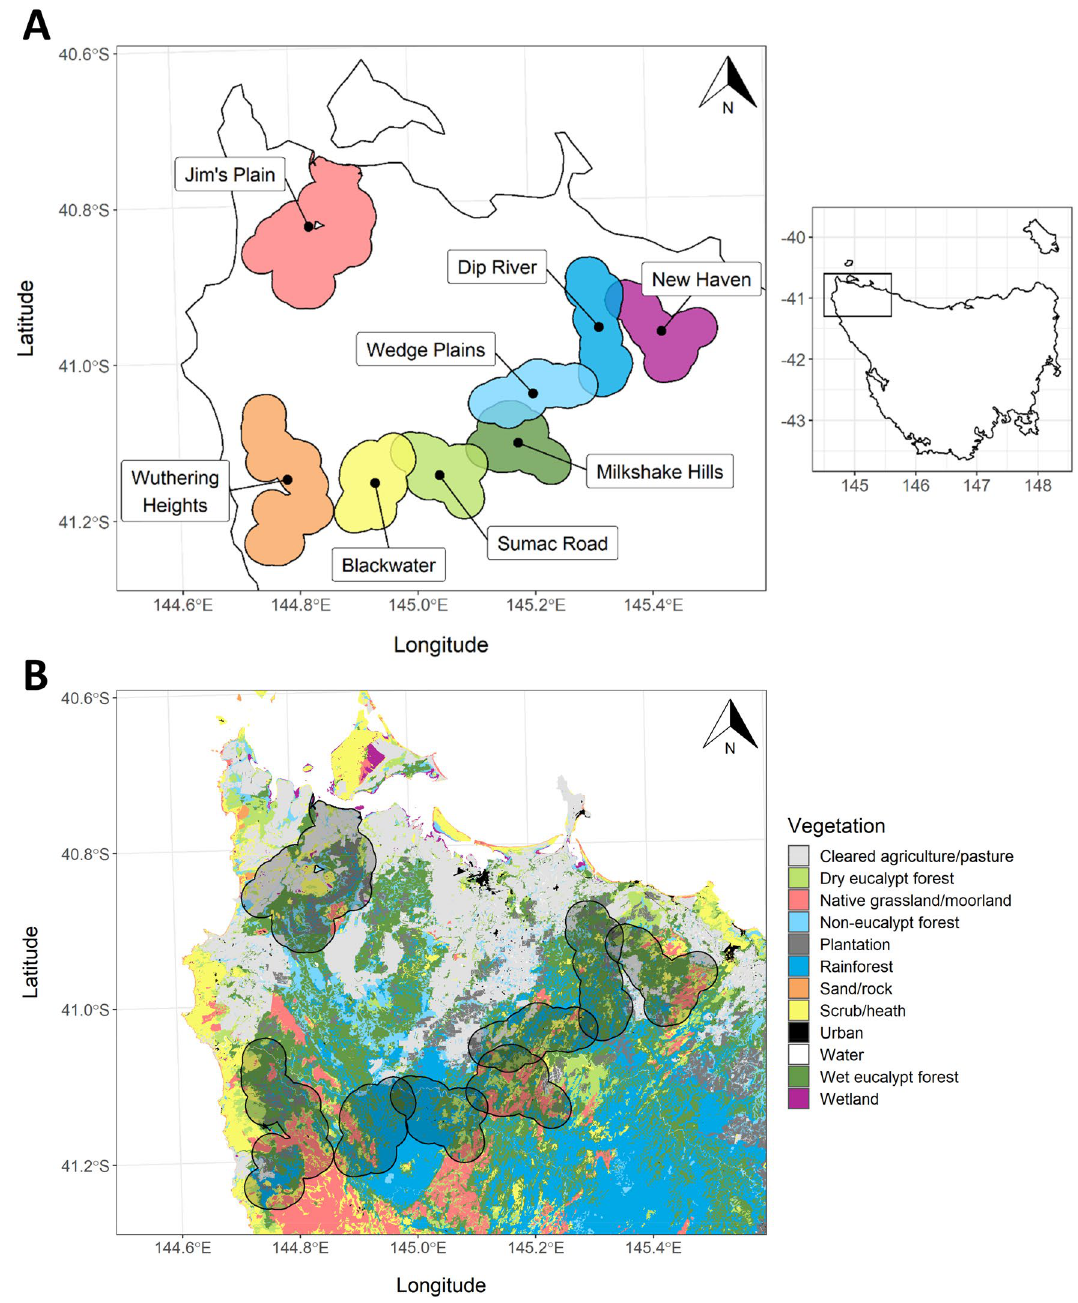
Figure 1. Map of north-west Tasmania, Australia generated using ArcGIS software 78 and indicating ( A ) eight study sites and ( B ) 12 vegetation groups present within the Circular Head region based on data from TASVEG 4.0 79